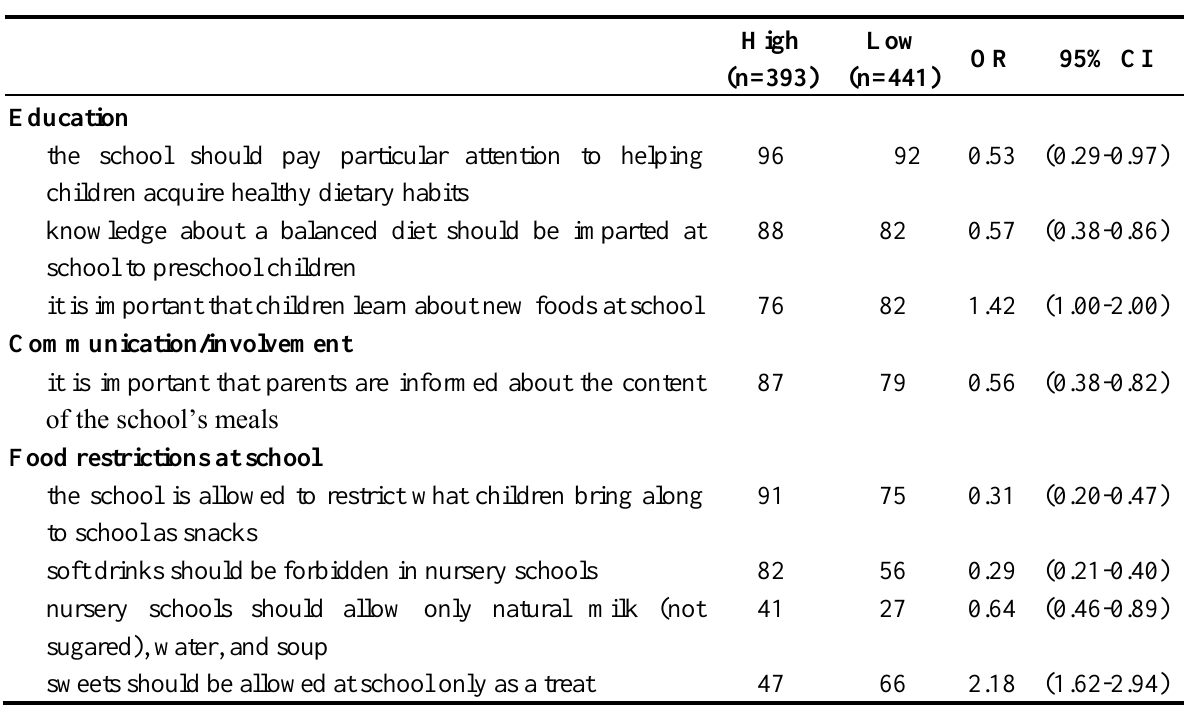
Table 3. Significant differences in parents‟ opinions by educational level of the responding parent.